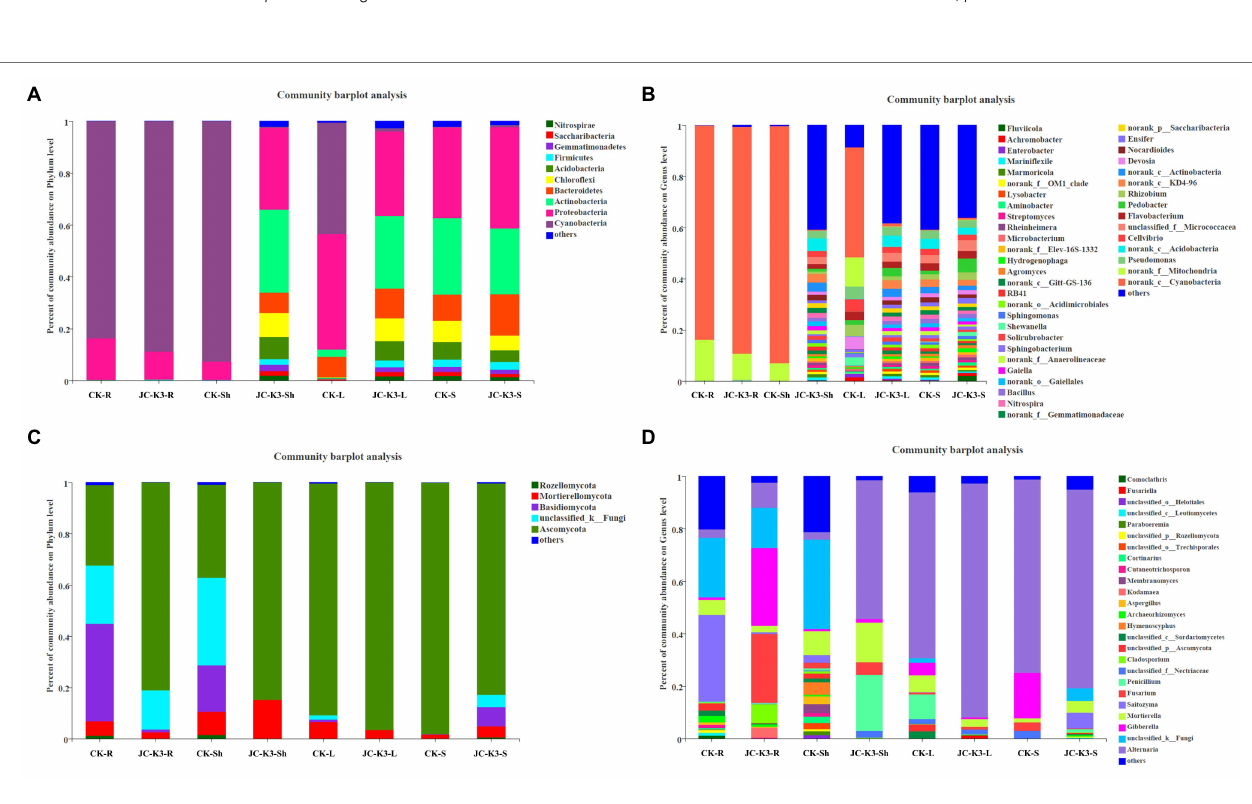
FIGURE 4 | Community structure of bacterial and fungal in two groups. The stacked bar graphs represent the relative abundances of the major phyla and genera. (A) Differences in bacterial community structure at the phylum level with different treatments; (B) Differences in bacterial community structure at the genus level with different treatments; (C) Differences in fungal community structure at the phylum level under different treatments; and (D) Differences in fungal community structure at the genus level with different treatments. CK and JC-K3 represent the control and JC-K3 inoculated plants, respectively. S, soil; R, roots; Sh, shoots; and L,